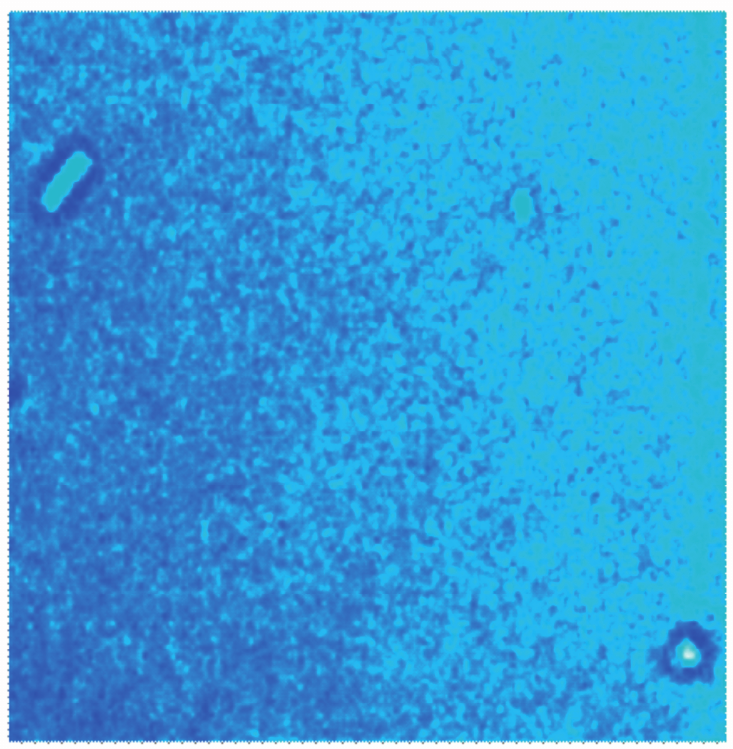
Figure 10. The transformation of Bacillus subtilis spores into the respective bacteria analyzed by light